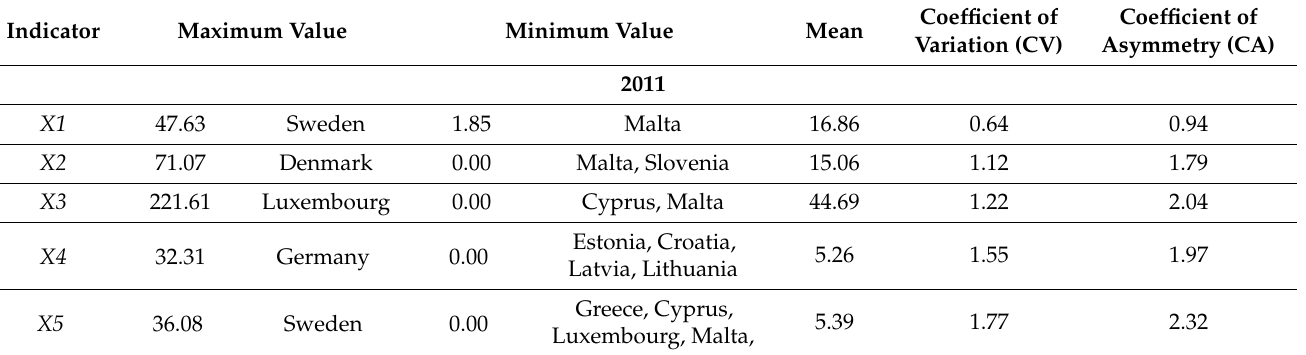
Table 1. Descriptive statistics of variables in 2011 and